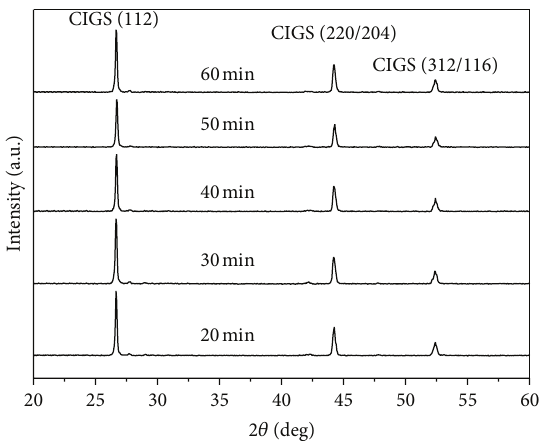
Figure 9: XRD patterns of the CIGS films selenized at 550 ∘ C for various soaking times.